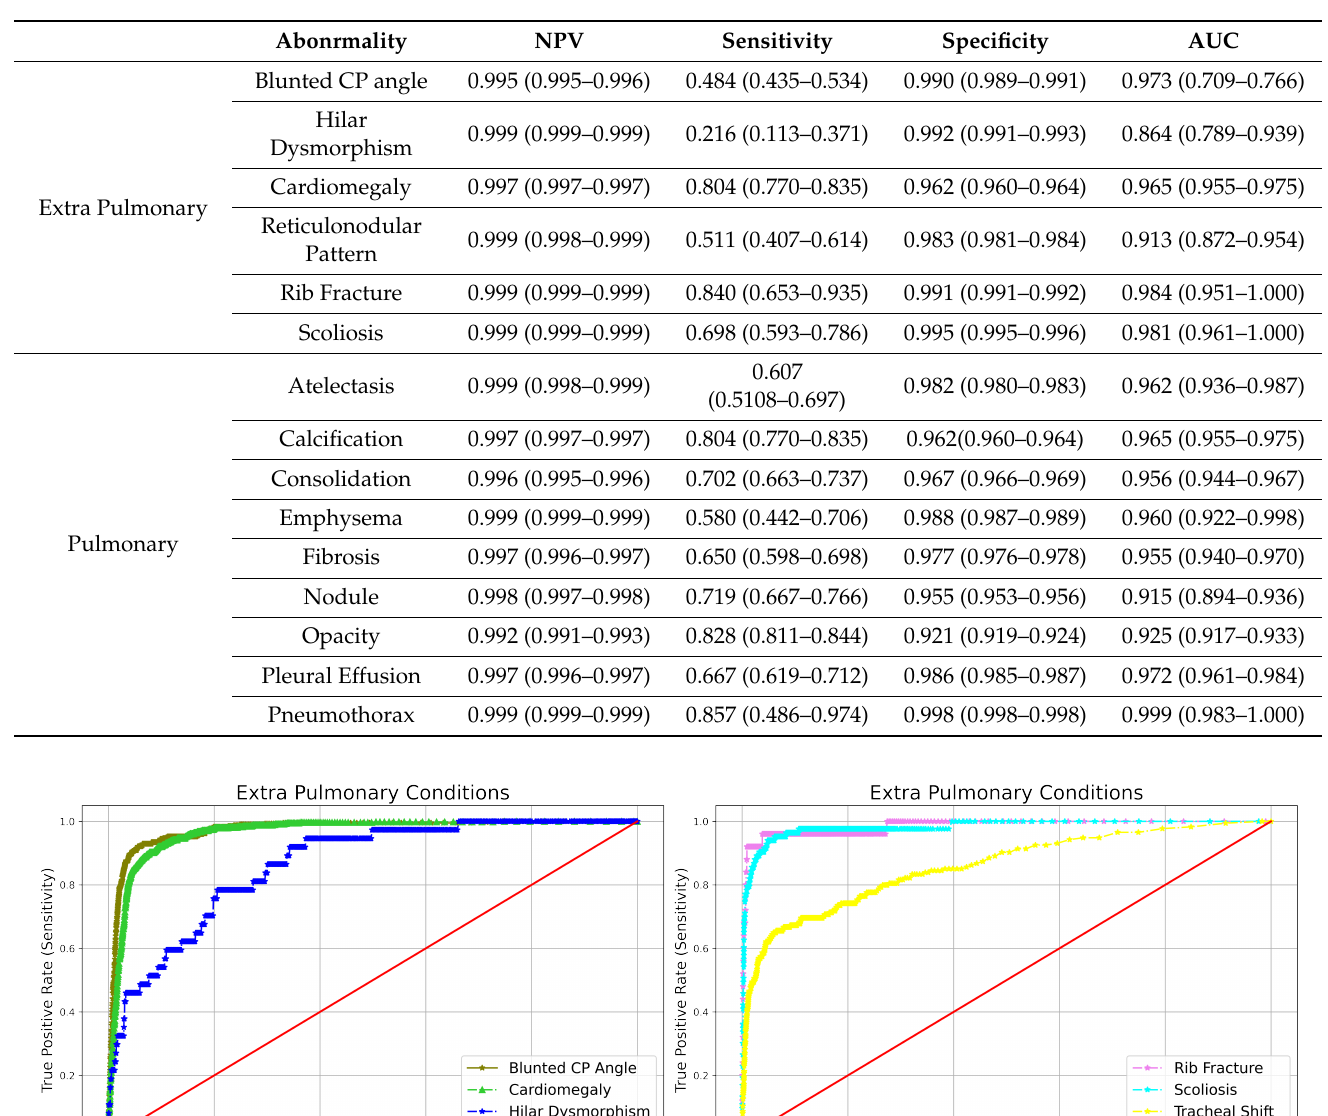
Table 3. Performance of qXR in categorizing abnormal CXR into subabnormalities by using radiologist as reference standard. Negative predictive value (NPV). Area under the curve (AUC).